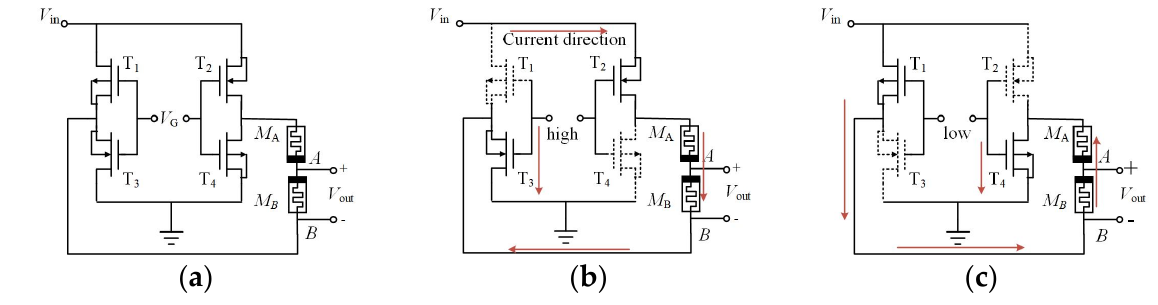
Figure 1. ( a ) Circuit diagram of the memristive synapse circuit; ( b ) current path with positive weight; ( c ) current path with negative weight.